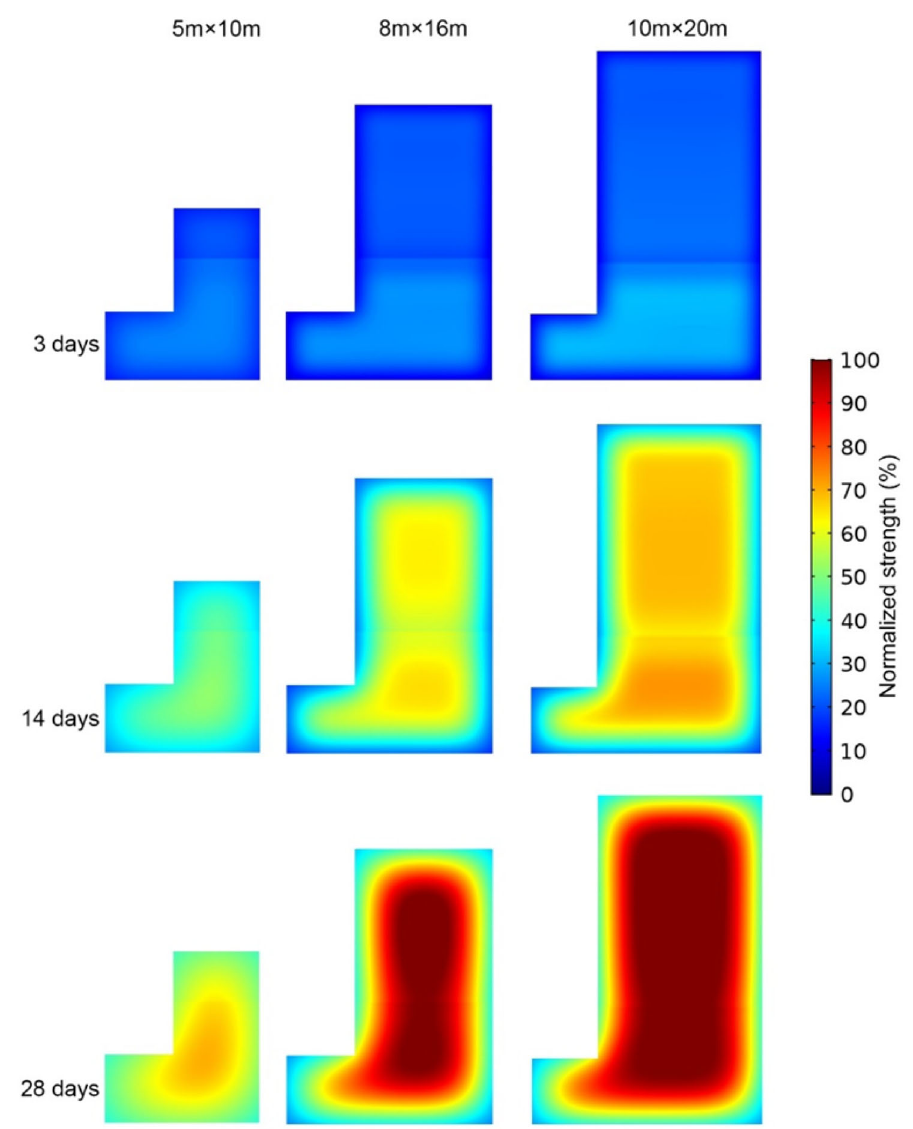
Fig. 15 Effect of stope size on spatial distribution of the strength CPB with higher binder content (Cement content 100 kg/m 3 i.e., 9.6